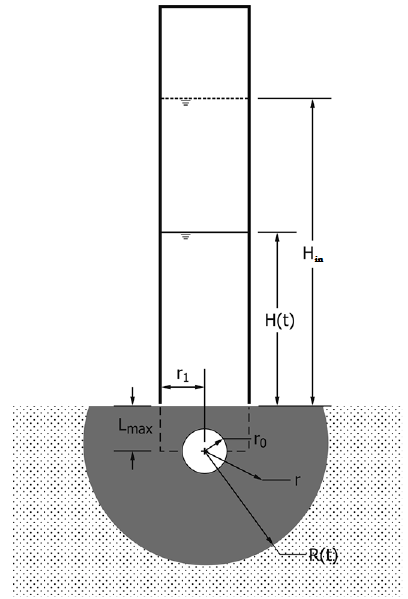
Figure 1. Notations used in the governing equations of the Modified Philip–Dunne Infiltrometer [33] .